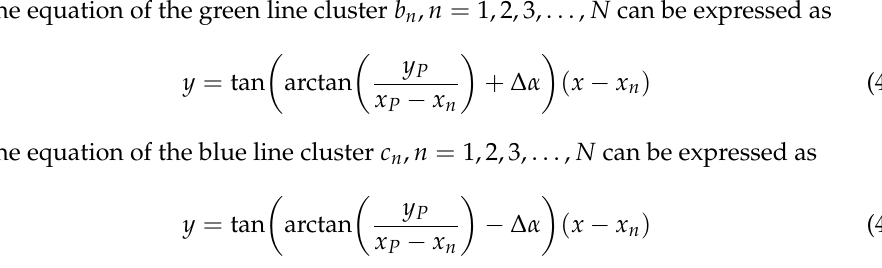
Figure 3. The effectively compensated area of emitter B ( x B , y B )